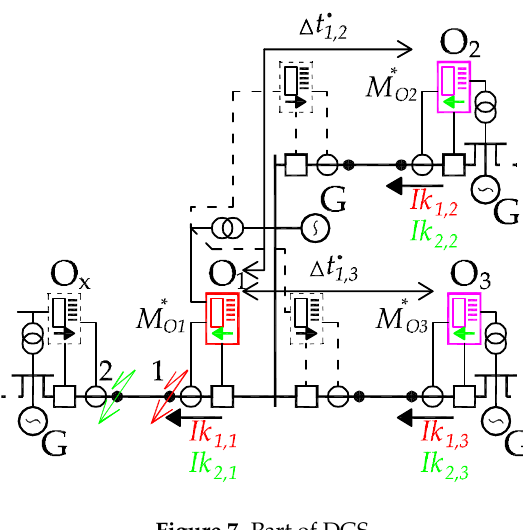
Figure 7. Part of DGS.